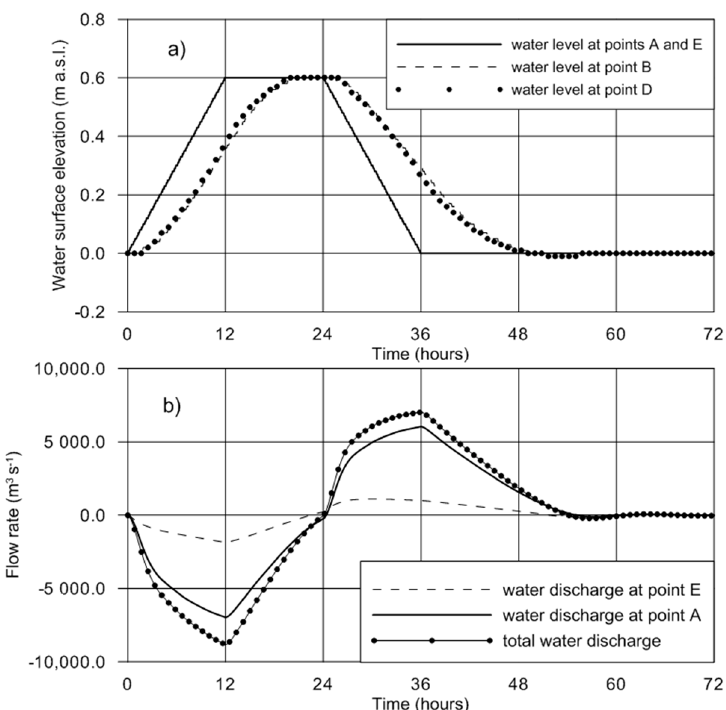
Figure 6. ( a ) Imposed boundary conditions (points A–Baltiysk and E–Nowy Ś wiat), and